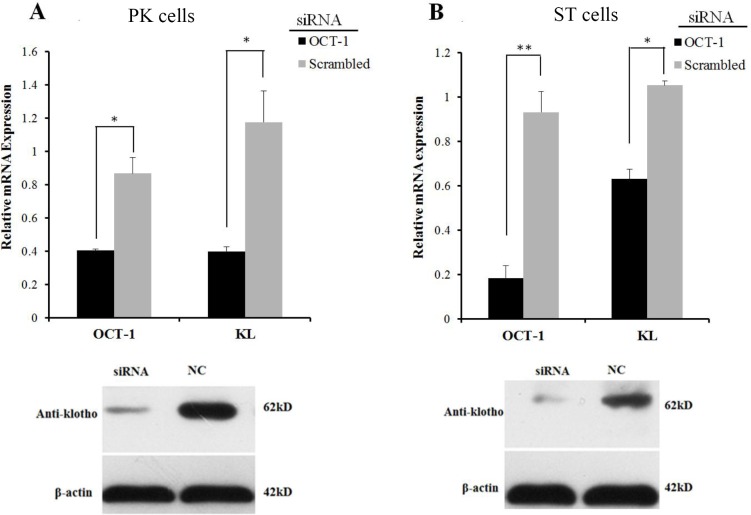
OCT-1 up-regulated KL expression by RNAi.(A) PK cells were treated with 2 µl OCT-1 siRNA and 2 µl NC for 24 h. Knockdown of OCT-1 was confirmed by qPCR. KL mRNA and protein expressions were analyzed by qPCR and Western blotting. (B) ST cells were treated with 2 µl OCT-1 siRNA and 2 µl NC for 24 h. Knockdown of OCT-1 was confirmed by qPCR analysis. KL mRNA and protein expressions were analyzed by qPCR and Western blotting. *P < 0.05. **P < 0.01. Relative mRNA expression was relative to the expression of β-actin.